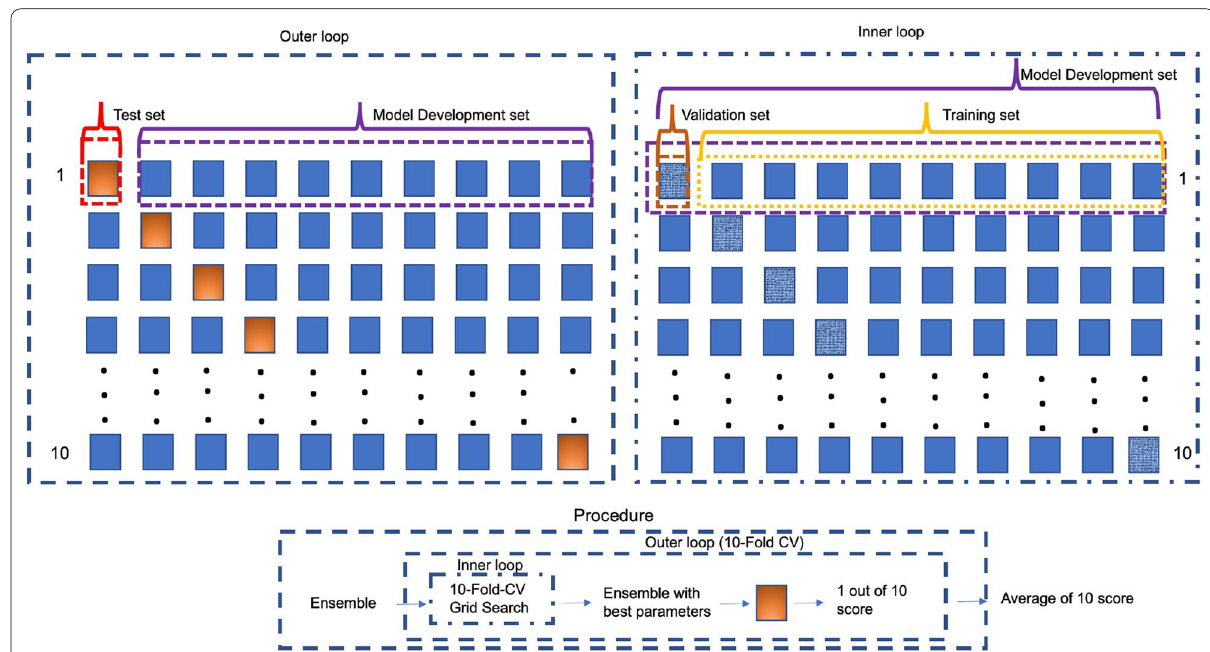
Fig. 1 Nested tenfold cross-validation (CV) procedure for model development and evaluation. In the outer CV loop (on top left), the dataset was partitioned into the ‘Model Development Set’ and ‘Test Set’. In the inner CV loop (on top right), the ‘Model Development Set’ was further partitioned into the ‘Training Set’ and ‘Validation Set’. The inner loop was composed of tenfold cross-validation Grid Search with the aim of obtaining the best parameters for each of the three classifiers assembled. On the bottom of figure, the procedure for one single iteration of the outer CV loop is graphed in diagram form